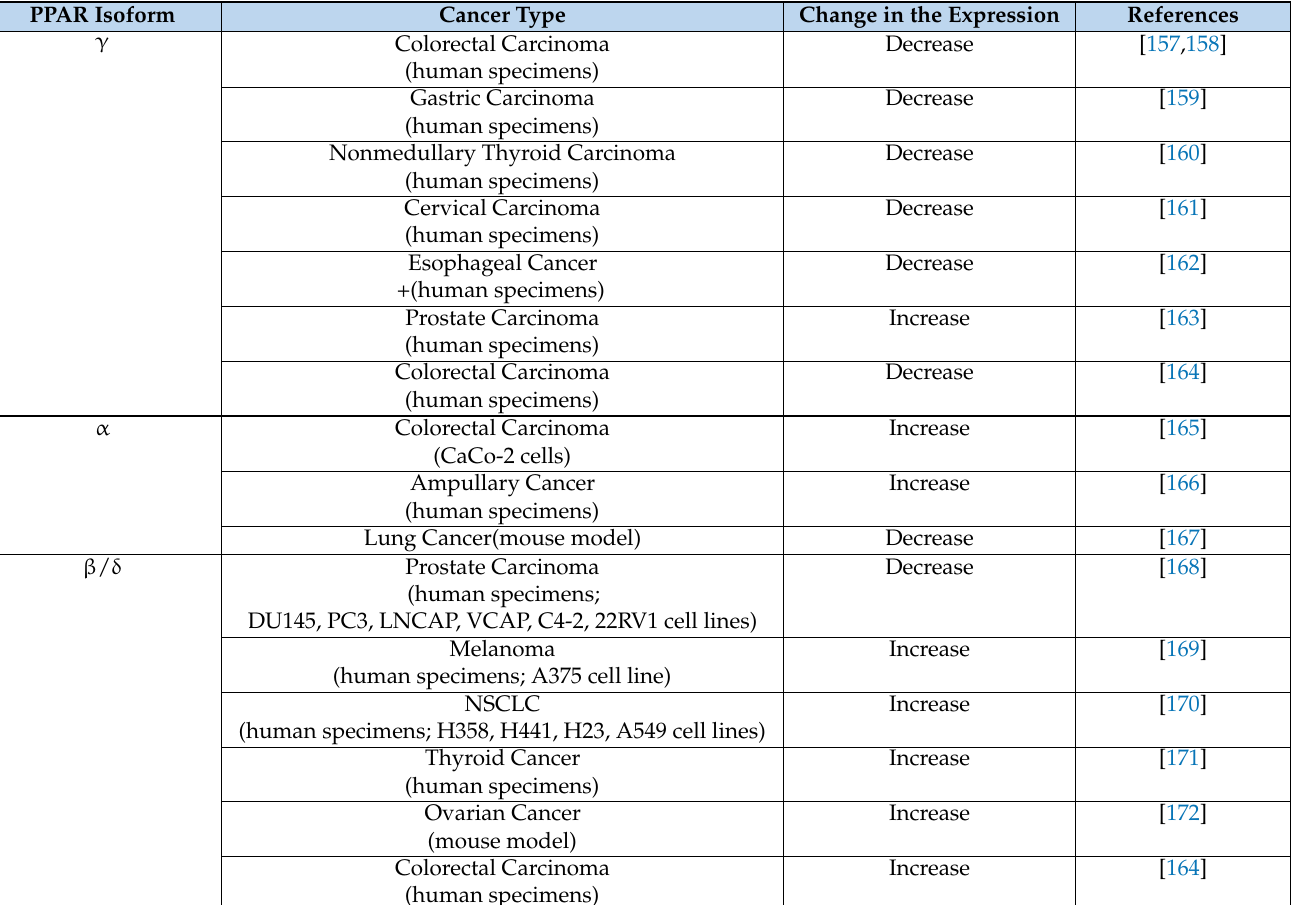
Table 4. PPAR expression in some cancers in comparison with corresponding normal cells/tissues. PPAR